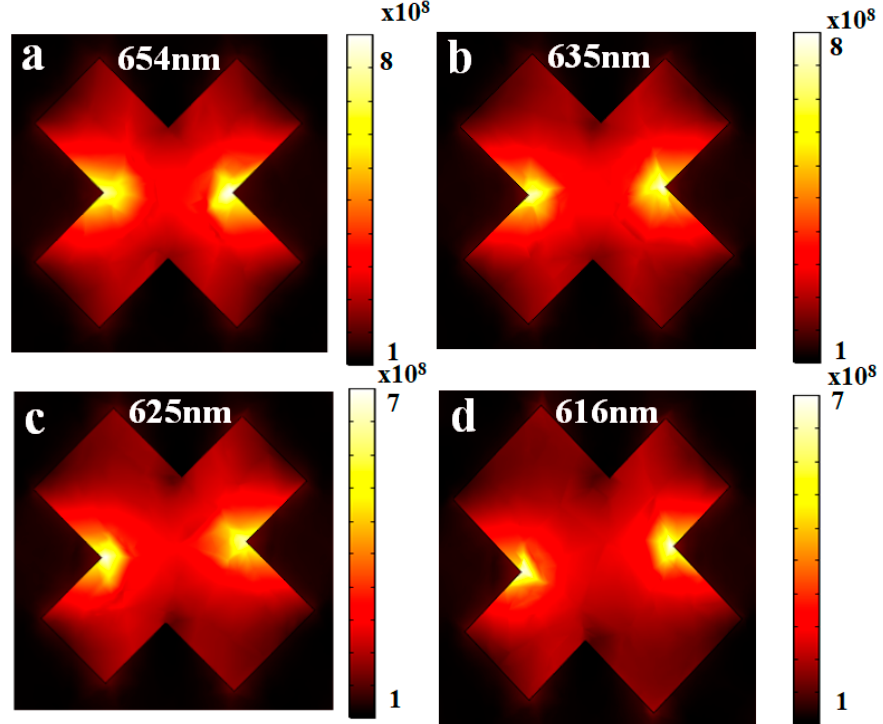
Figure 14. Electric field distribution at wavelengths 654 nm ( a ), 635 nm ( b ), 625 nm ( c ), and 616 nm ( d ) for defective structure for d6.